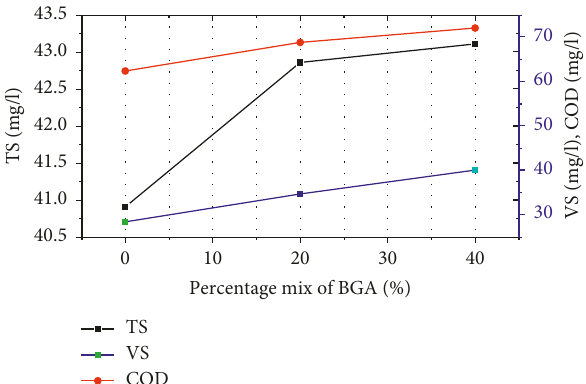
Figure 3: Removal efficiency of TS, VS, and COD at different mix ratios of MA.